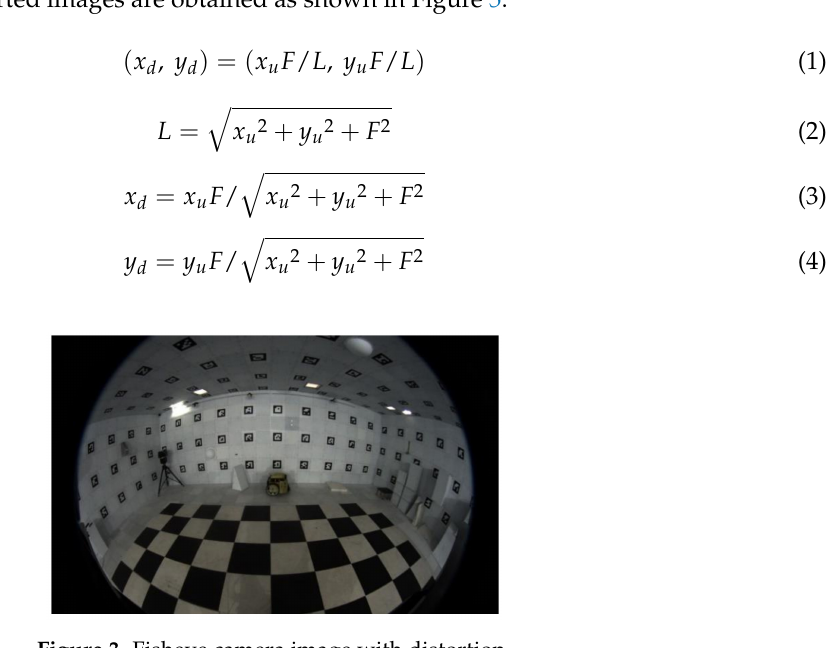
Figure 3. Fisheye camera image with